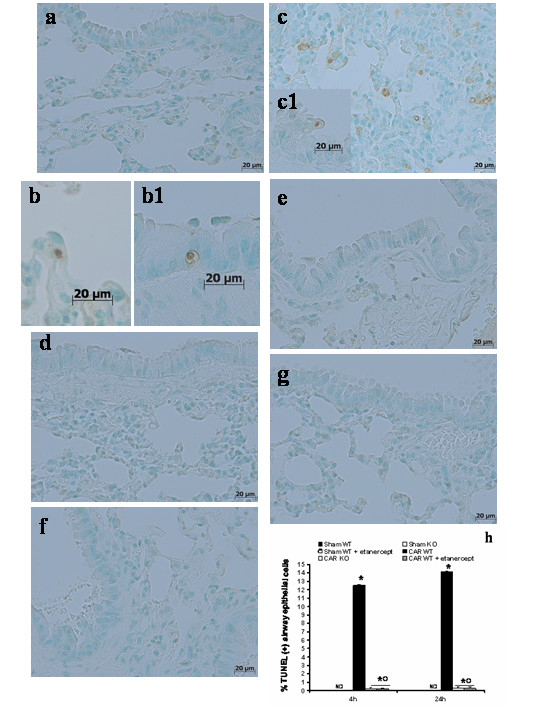
Effects of TNF-α gene deletion and Etanercept administration on apoptosis. Almost no apoptotic cells were detected in the lung from sham-treated (a) tissues collected at 24 hours. At 4 h (bb1) and 24 h (cc1) after the induction of lung inflammation by carrageenan administration, lung tissues demonstrated a marked appearance of dark brown apoptotic cells and intercellular apoptotic fragments. The presence of apoptotic cells or fragments were significantly reduced in the absence of a functional TNF-α R1 gene in TNF-αR1KO mice at 4 h (d) and at 24 hours (e) after carrageenan. Similarly, the treatment of WT mice with Etanercept (5 mg/kg administered sc 2 h prior carrageenan) visibly and significantly reduced the number of apoptotic cells or fragments in the lung tissues collected at 4 h (f) and at 24 hours (g). The graph (h) shows the mean ± SE of percentage TUNEL positive epithelial cells in biopsies from mice in all the experimental groups. *P < 0.01 vs. SHAM; °P < 0.01 vs. carrageenan- WT group ND: not detectable. Figure is representative of at least 3 experiments performed on different experimental days.